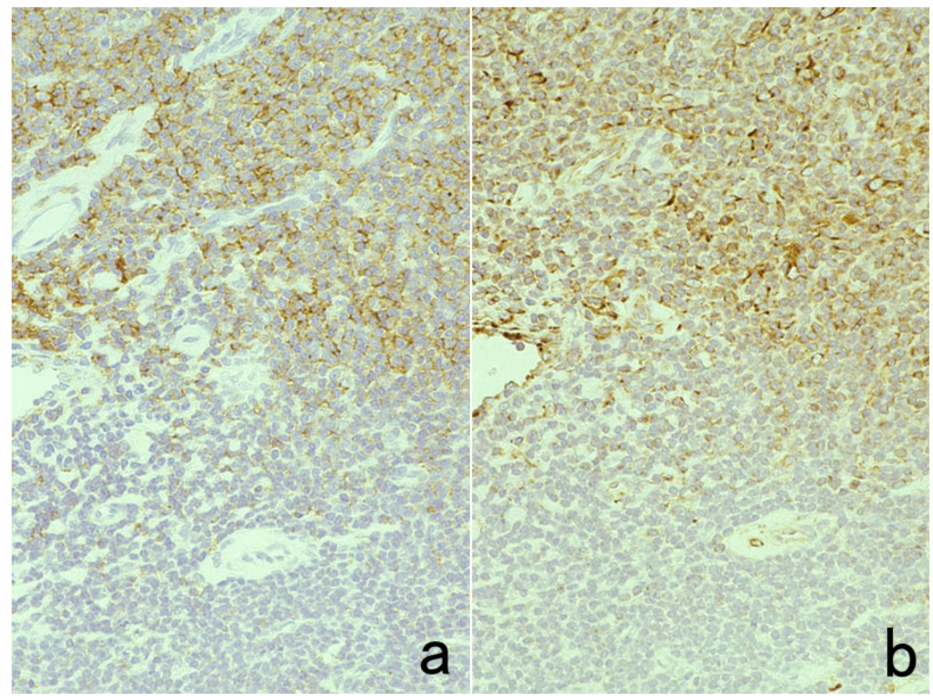
Figure 14. Vimentin internal control. Diffuse large B-cell lymphoma. ( a ): Vimentin and ( b ): CD20. The poorly fixed central part (representing the lower half of the panels) is false negative for both vimentin and CD20. The expression of lymphocyte surface markers should be judged based on the positivity in the appropriately fixed peripheral area (the upper half of the panels).